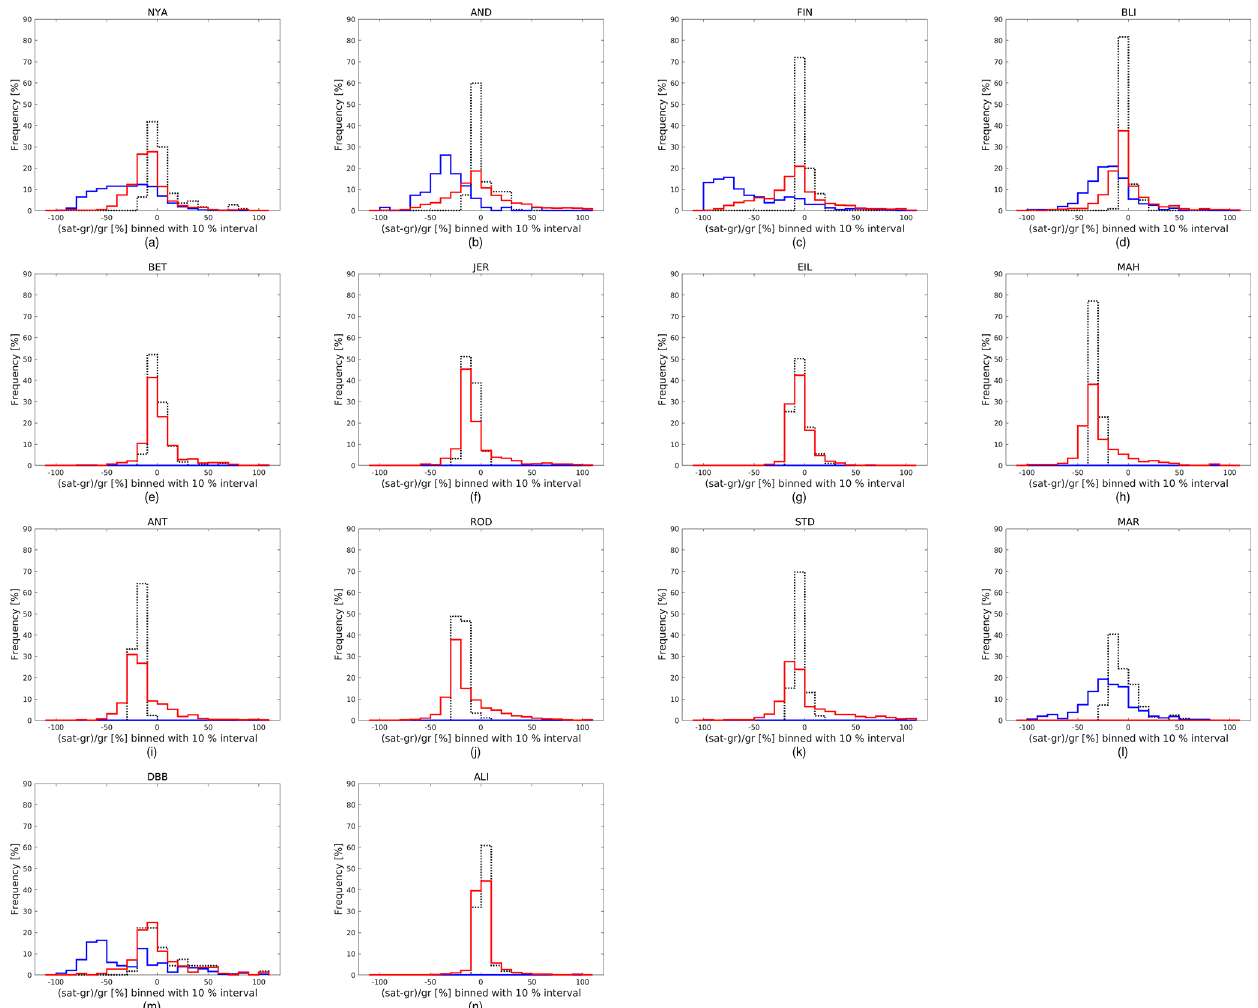
Figure 6. Histograms of relative difference between radiometer measurements and satellite overpass UV index at (a) Ny-Ålesund, (b) Andøya, (c) Finse, (d) Blindern, (e) Bet Dagan, (f) Jerusalem, (g) Eilat, (h) Mahé, (i) Antananarivo, (j) Anse Quitor, (k) Saint-Denis and (l) Marambio and overpass erythemally weighted dose rates at (m) Davos and (n) Alice Springs. The black dotted line denotes cloud-free conditions, the red one a snow-free surface and the blue one snow cover on the